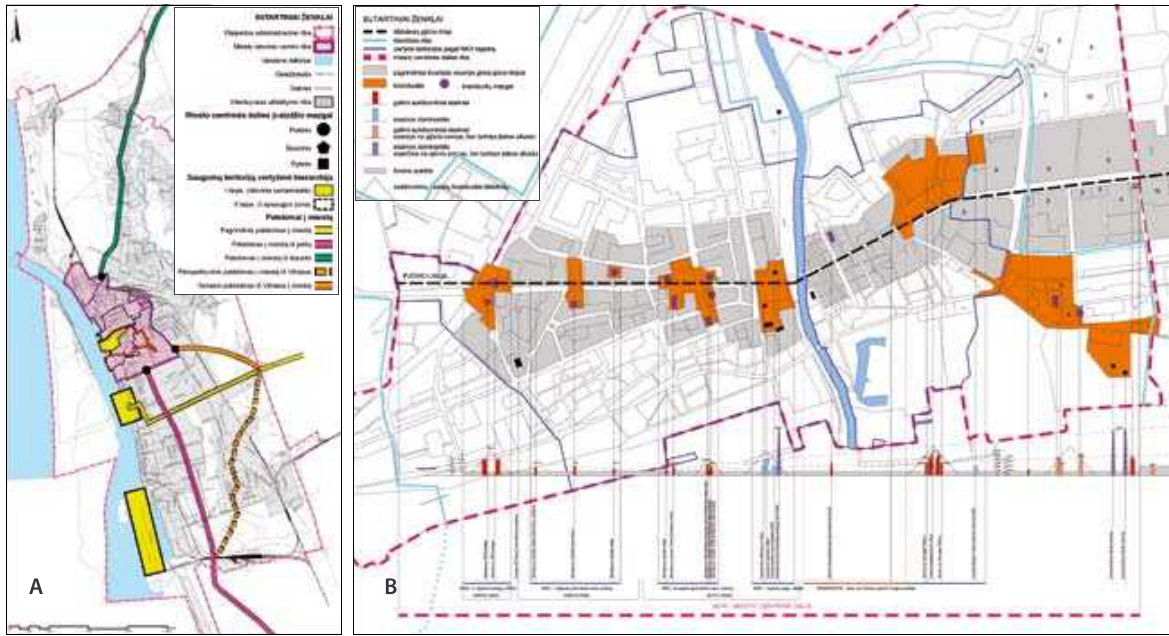
Fig. 5. Emphasis of the compositional structure of the city: A – the main compositional nodes on a city scale; b – composi- tional nodes of H. Mantas st on a central-part